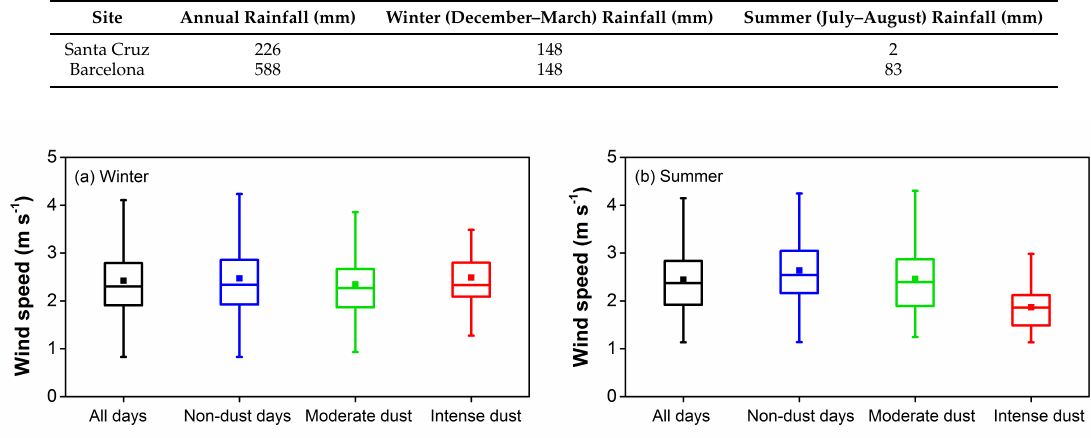
Figure A2. Mean daily surface wind speed (2012 to 2017) calculated for all days, non-dust outbreak days, and different intensities of dust outbreaks during ( a ) winter (December–March) and ( b ) summer (July–August): The horizontal lines and the squares within the box represent the median and mean values, respectively, while the bottom and top of each box are the 25th and 75th percentiles. The whiskers are the 5th and 95th